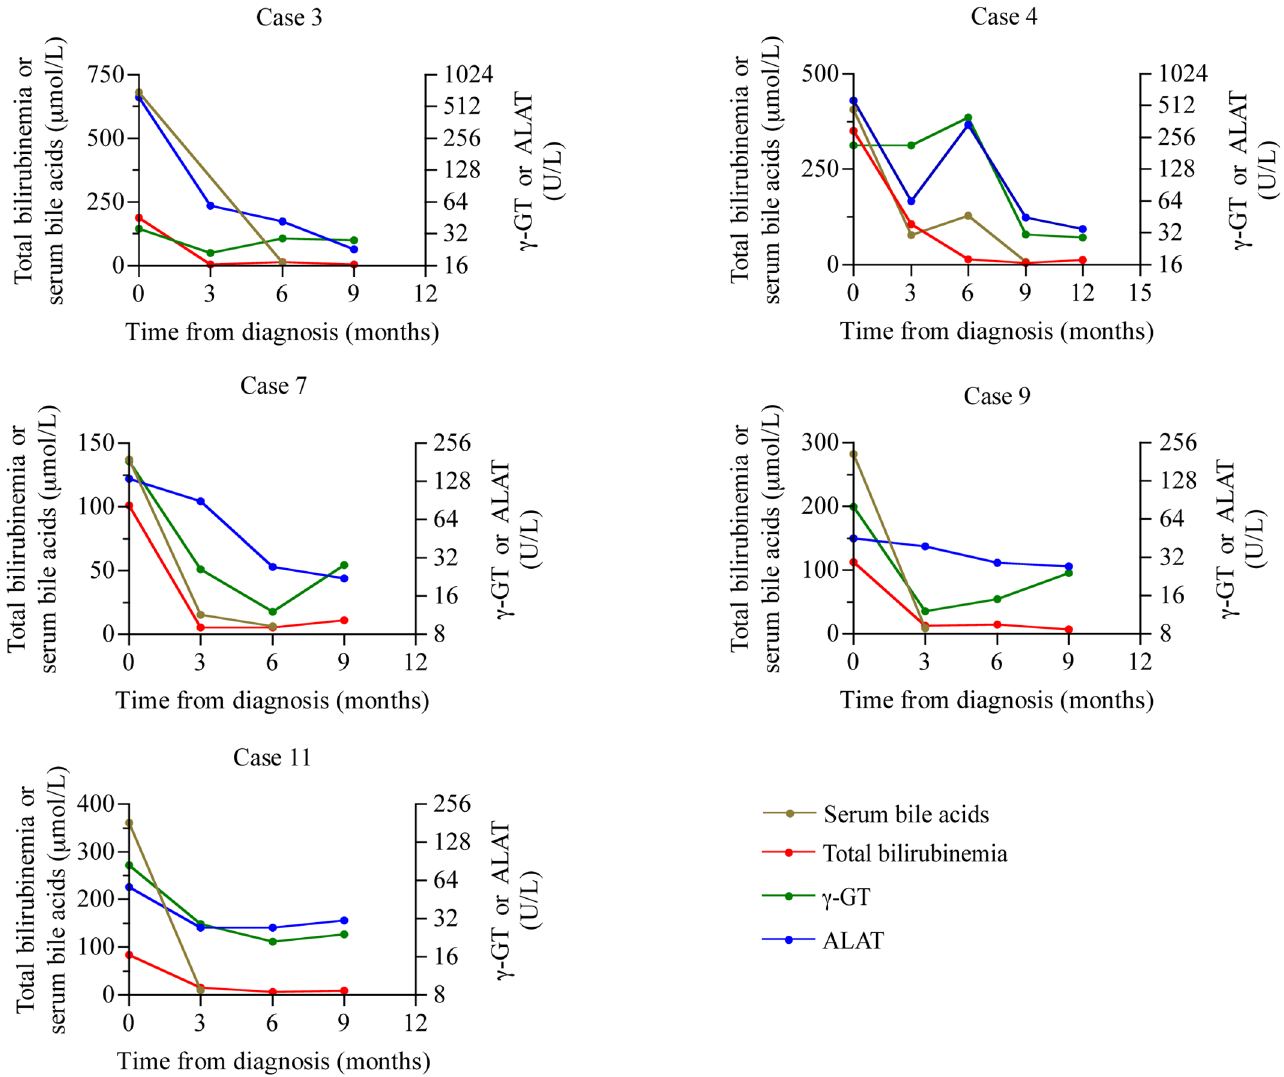
Fig 1. Evolution of serum bile acids, bilirubin, γ -GT and ALT levels with age (time from diagnosis) in the 5 PSIS patients with